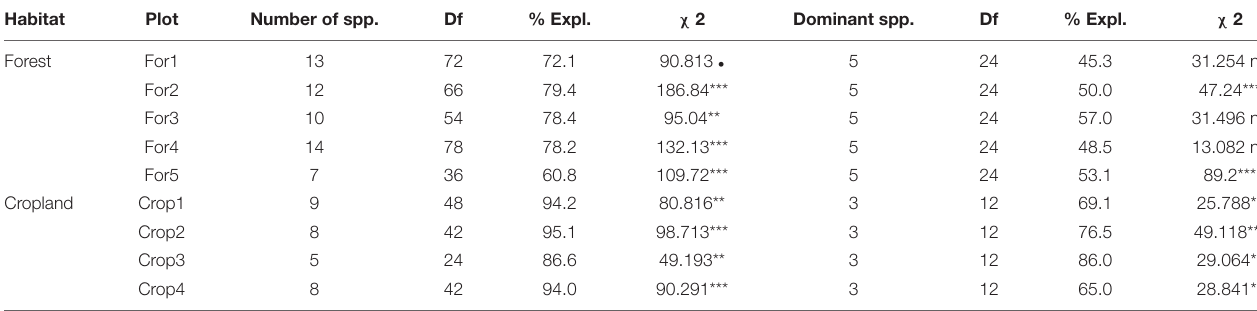
TABLE 3 | Contingency tests calculated on trophic partitioning matrices on five forest and four cropland assemblages. Habitat Plot Number of spp. Df % Expl.